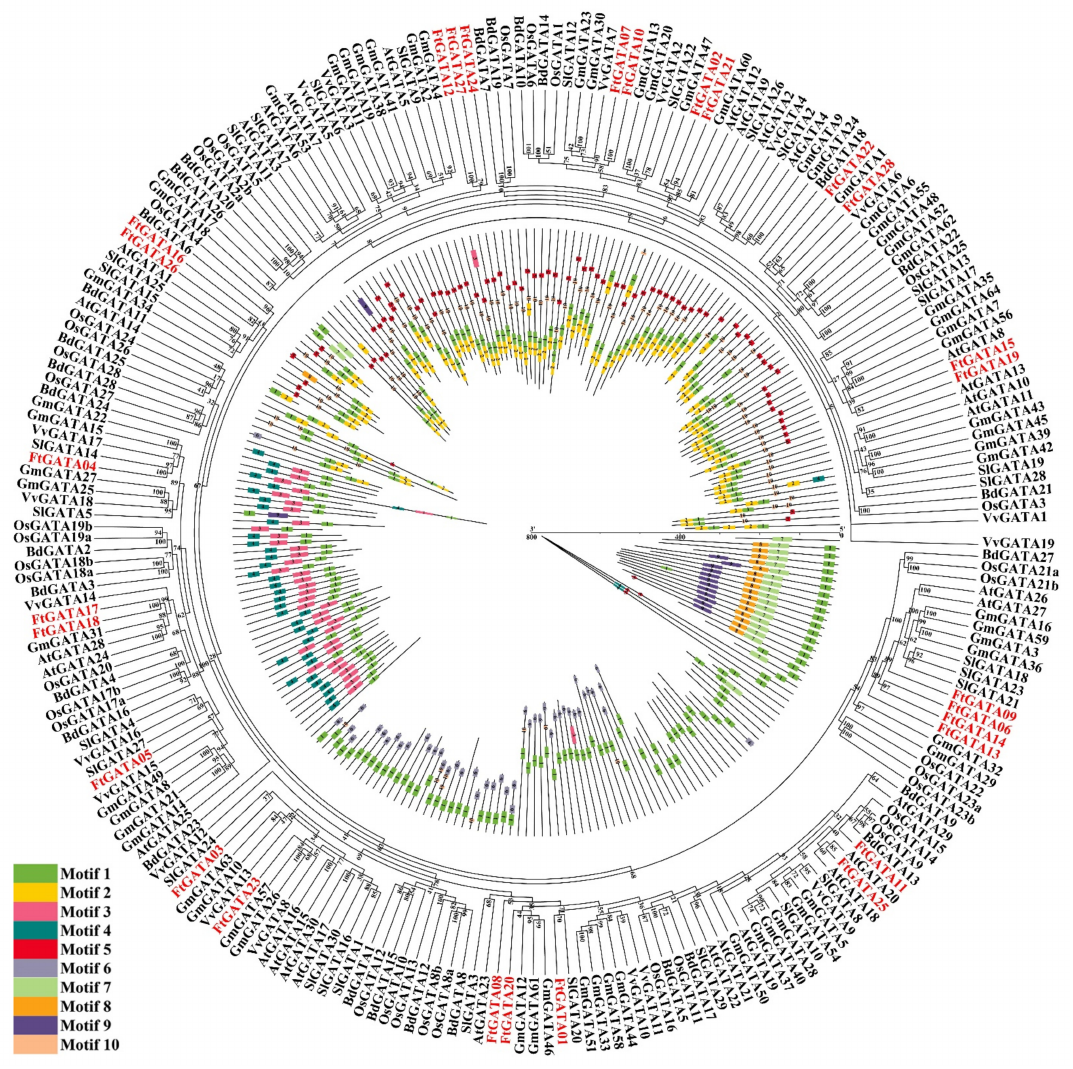
Figure 6. Phylogenetic relationship and conserved motifs of GATA protein in Fagopyrum tataricum and six plants ( Glycine max , Vitis vinifera , Solanum lycopersicum , Arabidopsis thaliana , Brachypodium distachyon , and Oryza sativa ). The red fonts represent the 28 FtGATA genes identified in this paper. The colored legends represent 10 motifs, the outer part of the circle represents the phylogenetic tree of GATA proteins, and the inner part of the circle represents different conserved motifs and protein